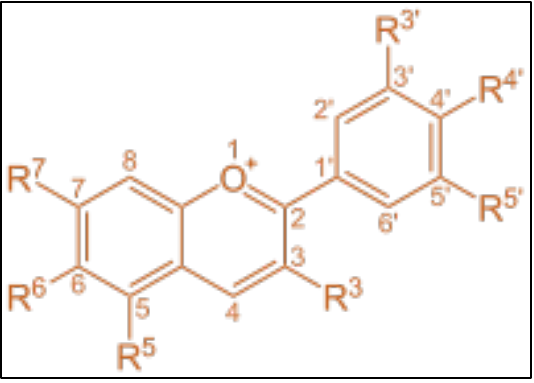
Figure 2. Structure of anthocyanins.